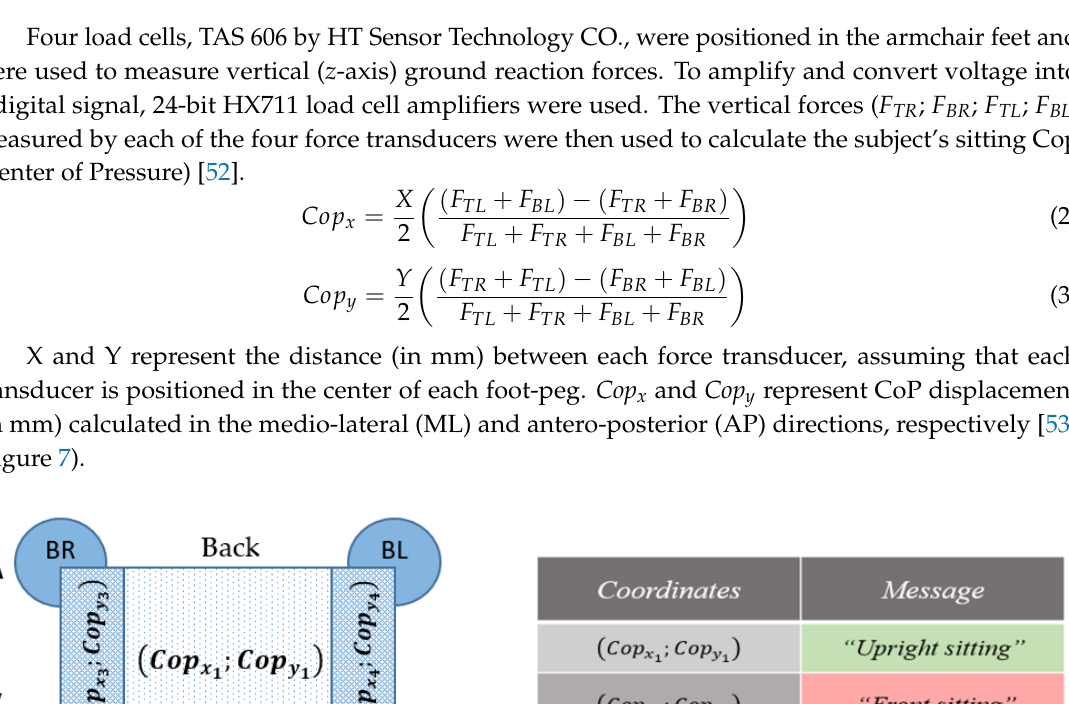
Figure 6. Photograph of the developed smart armchair.